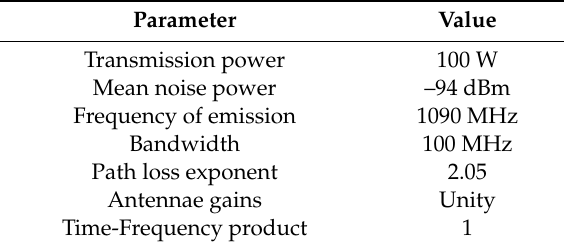
Table 1. Parameters of configuration for the positioning system operation. Their selection is based on [19,34].